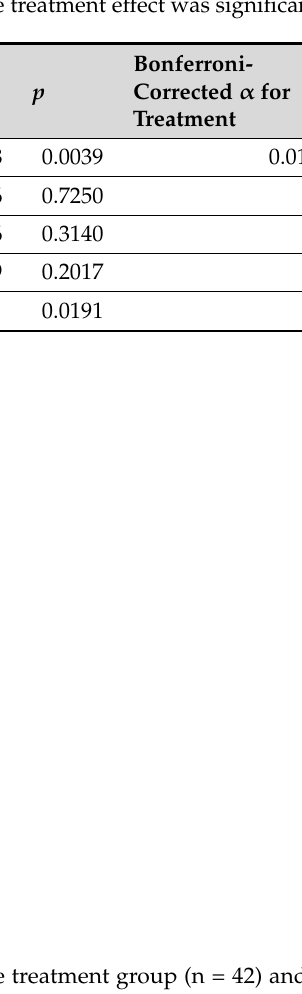
Table 9. Results of the linear mixed-effects model assessing the effect of treatment, age, litter size, and sex on “PC 3—Novel Object”. The p -value for litter refers to the ANOVA comparing the models with and without litter included. “Bonferroni-corrected α for treatment” indicates the alpha level (after sequential Bonferroni correction) to determine whether the treatment effect was significant.